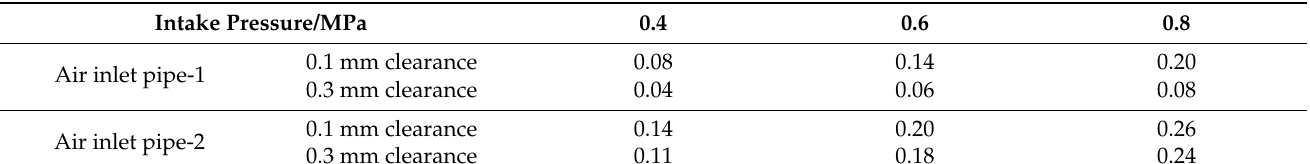
Figure 17. Intake pipe section. Table 2. Static pressure for multiple working conditions.